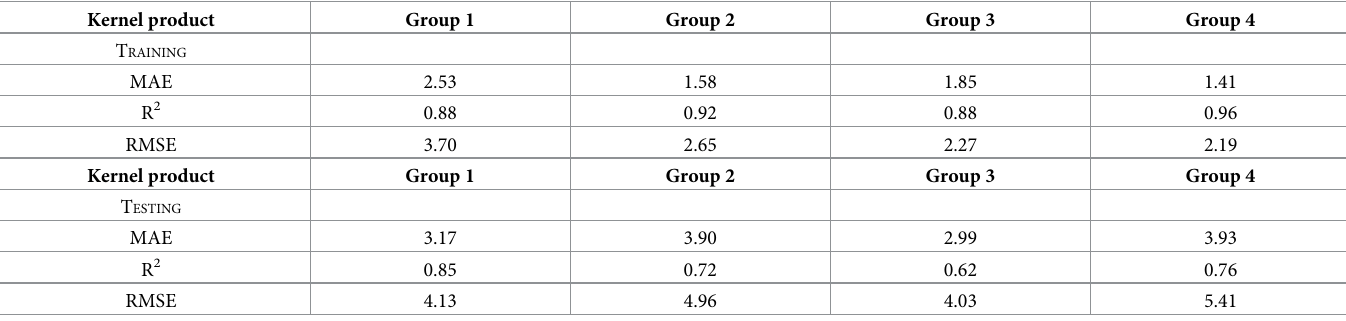
Table 4. SVR proposal performance: Training and testing by groups of gender and age. Kernel